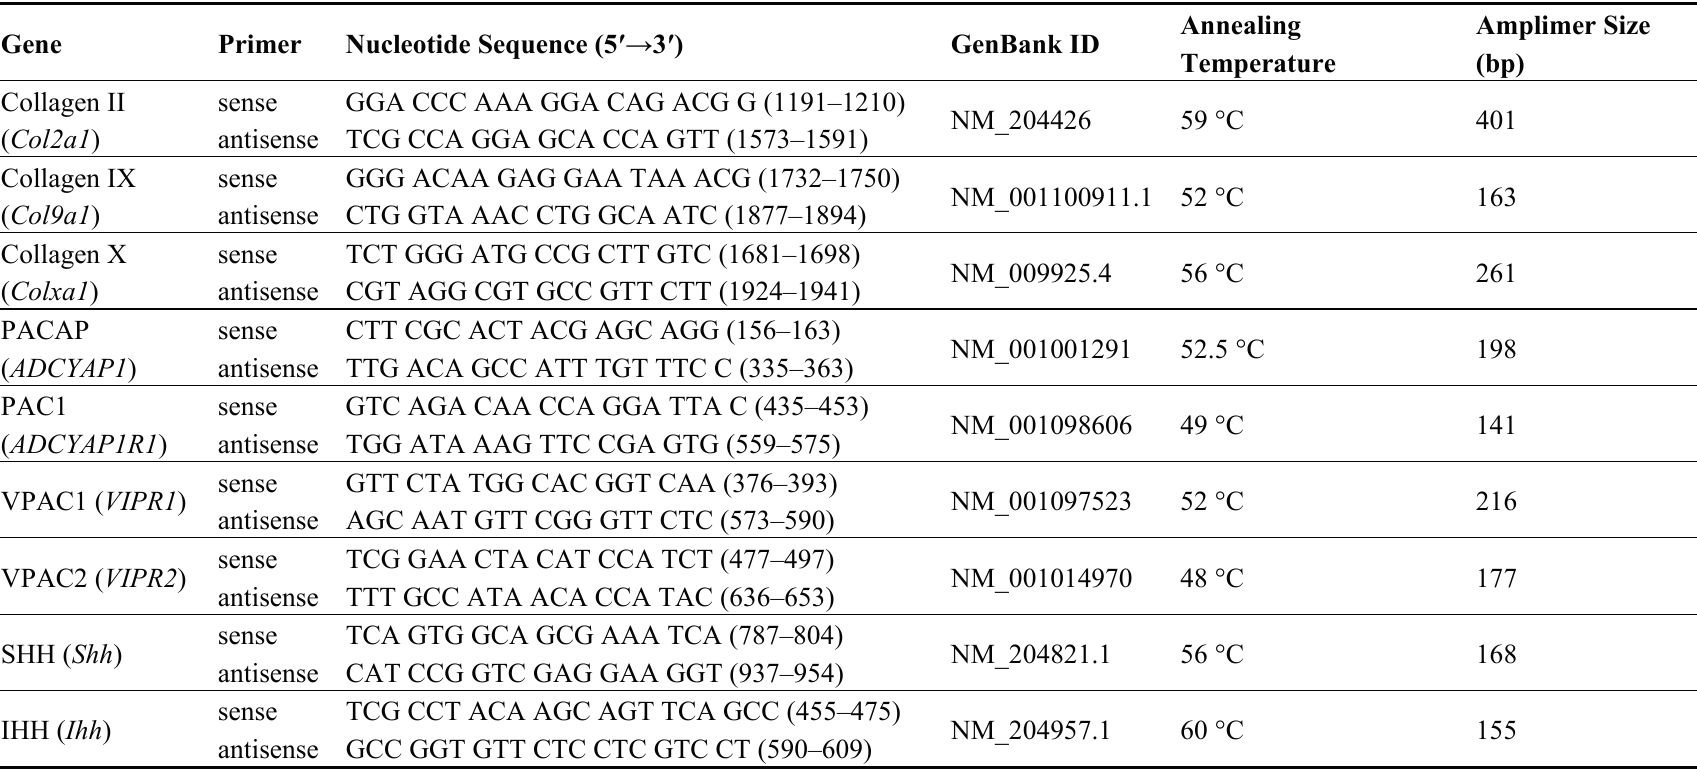
Table 1. Nucleotide sequences, amplification sites, GenBank accession numbers, amplimer sizes and PCR reaction conditions for each primer pair are